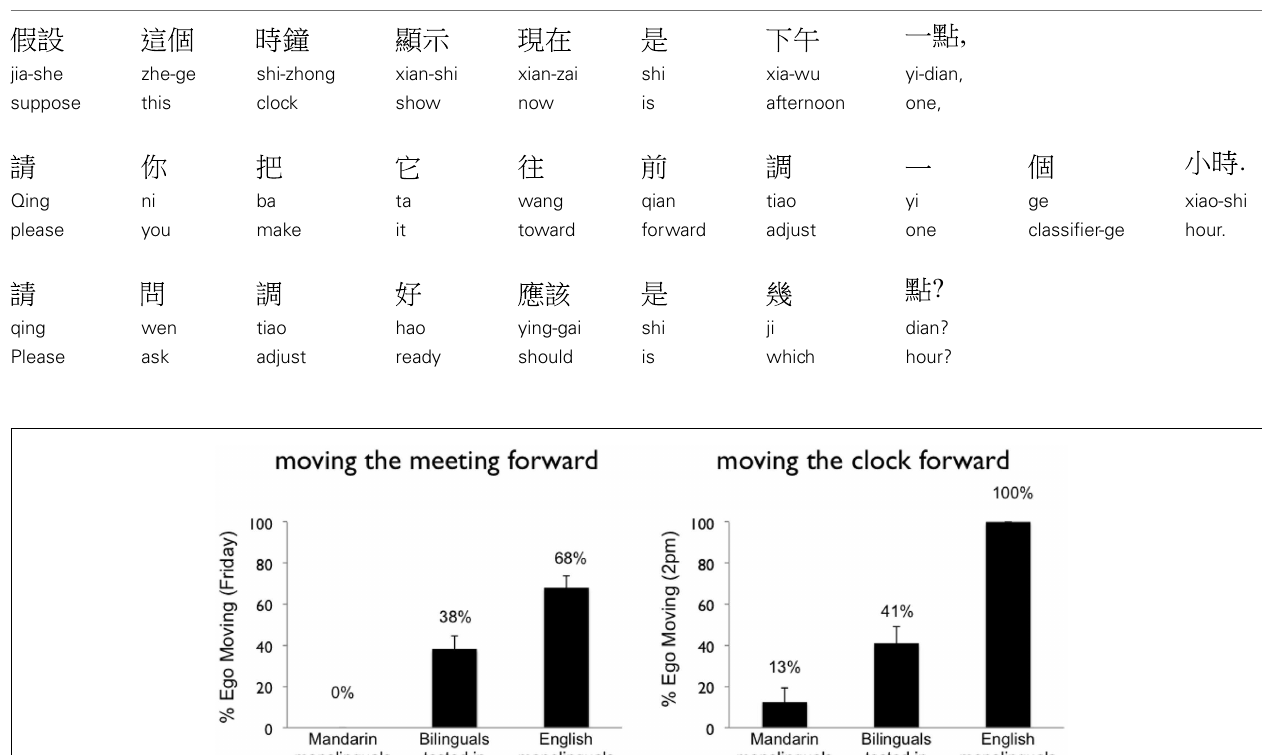
Table 3 |The “clock” question in English (top) and Mandarin (bottom).